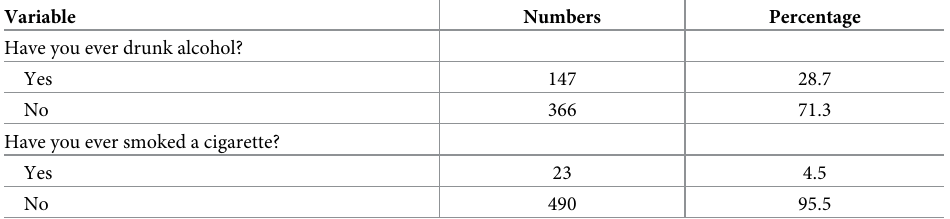
Table 5. Alcohol use, smoking cigarettes, and chronic conditions of respondents in Welkite town of Southern Ethiopia, 2020, [n =